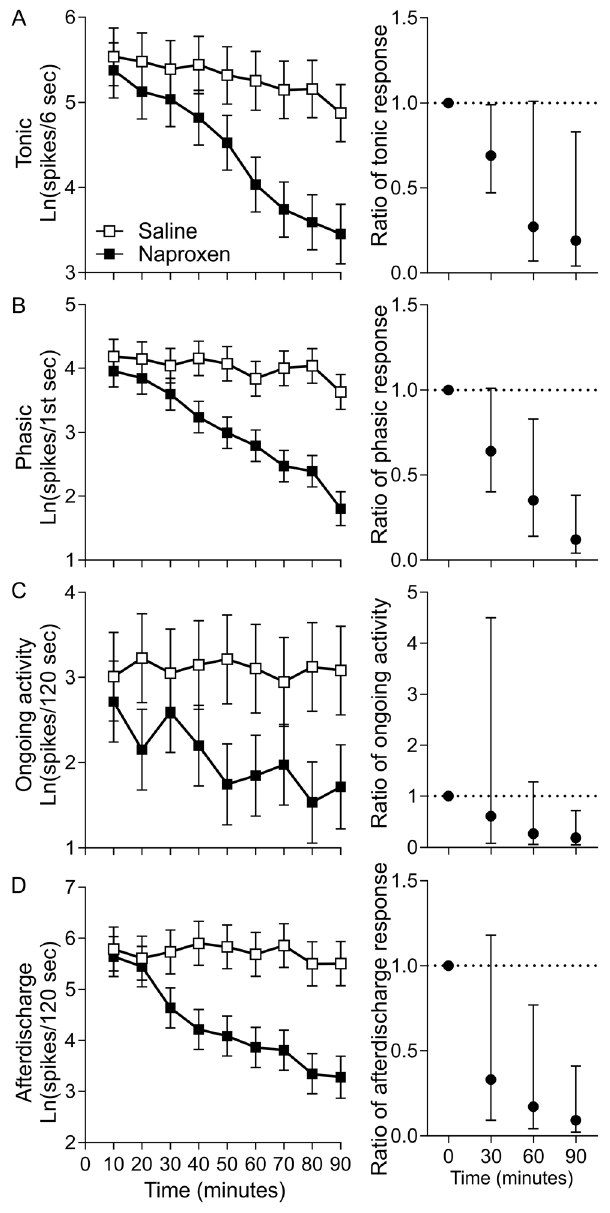
Figure 4. Effects of naproxen on spinal dorsal horn neuronal activity. Each row shows the results for an exploratory endpoint with ANCOVA adjusted means on the left (error bars 6 sem) and the ratios of adjusted means for naproxen/saline on the right (error bars 6 95%CI). Ratio graphs focus on 0, 30, and 60 minutes, the time points at which these animals were determined to have (mean 6 sem) 0 6 0 nM, 165 6 28 nM and 697 6 45 nM free plasma concentration of naproxen respectively and 90 minutes which is after 30 minutes of no infusion resulting in 567 6 34 nM free plasma concentration. (A) tonic spike count during the six seconds following phasic spiking (B) phasic spiking during the first one second after rotation onset (C) ongoing activity quantified during the 120 seconds preceding each stimulus set and (D) afterdischarge during the 120 seconds following the last rotation of each